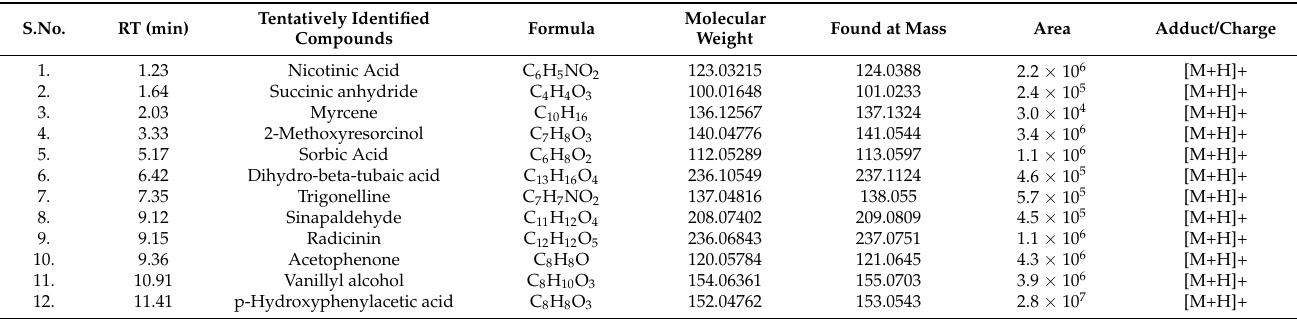
Table 5. Metabolite profiling of the ethyl acetate extract of Penicillium lanosum (EAE-PL) by LC- MS/MS analysis. RT, retention